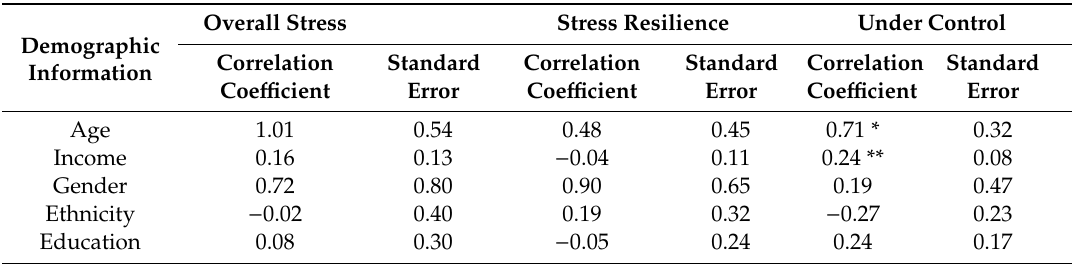
Table 3. Multiple Regressions between Five Demographic Variables and Health Outcomes of Perceived Stress Scale (PSS).